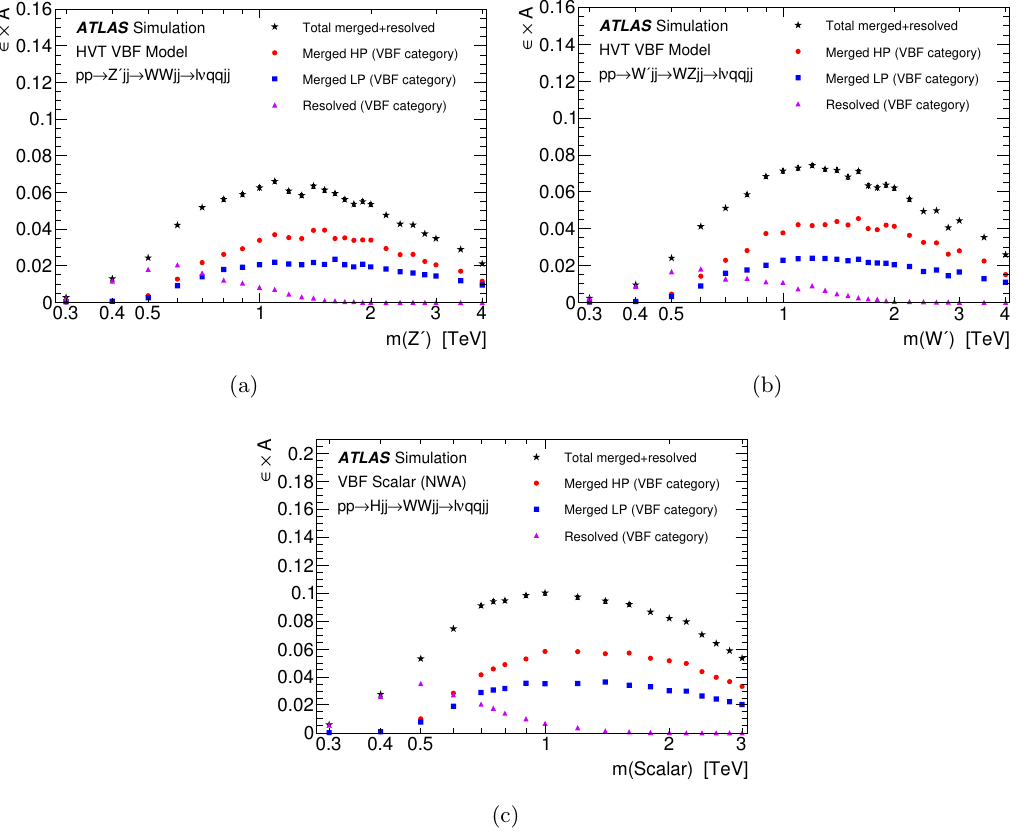
Figure 2 . The product of signal e(cid:14)ciency ( (cid:15) ) and acceptance ( A ) for signals produced via the VBF mechanism is presented in the VBF category. The (cid:15) (cid:2) A is shown for (a) HVT WW ! ‘(cid:23)qq , (b) HVT WZ ! ‘(cid:23)qq and (c) neutral scalar signal ( H ) in the narrow-width approximation (NWA) decaying into ‘(cid:23)qq in the various analysis signal regions. It is de(cid:12)ned as the ratio of the number of signal events reconstructed in the signal region to the number of generated signal